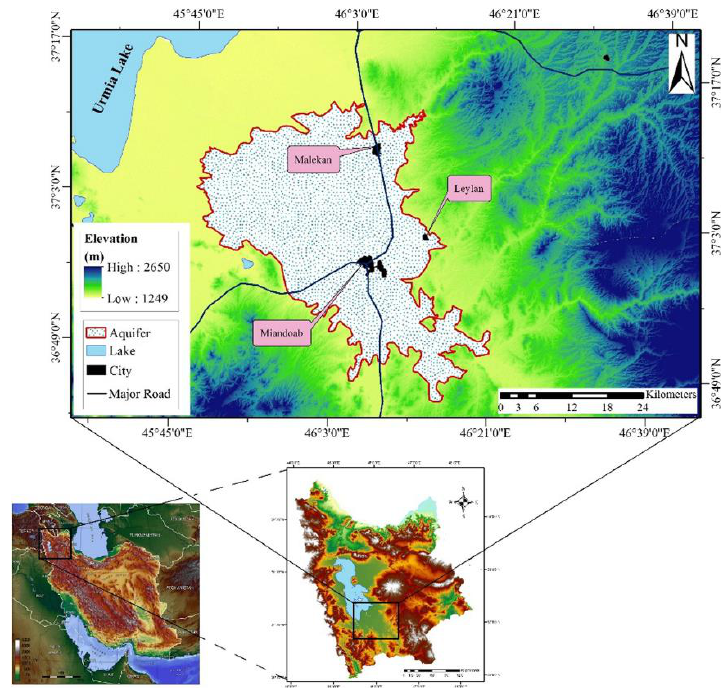
Figure 1. Geographical location map.